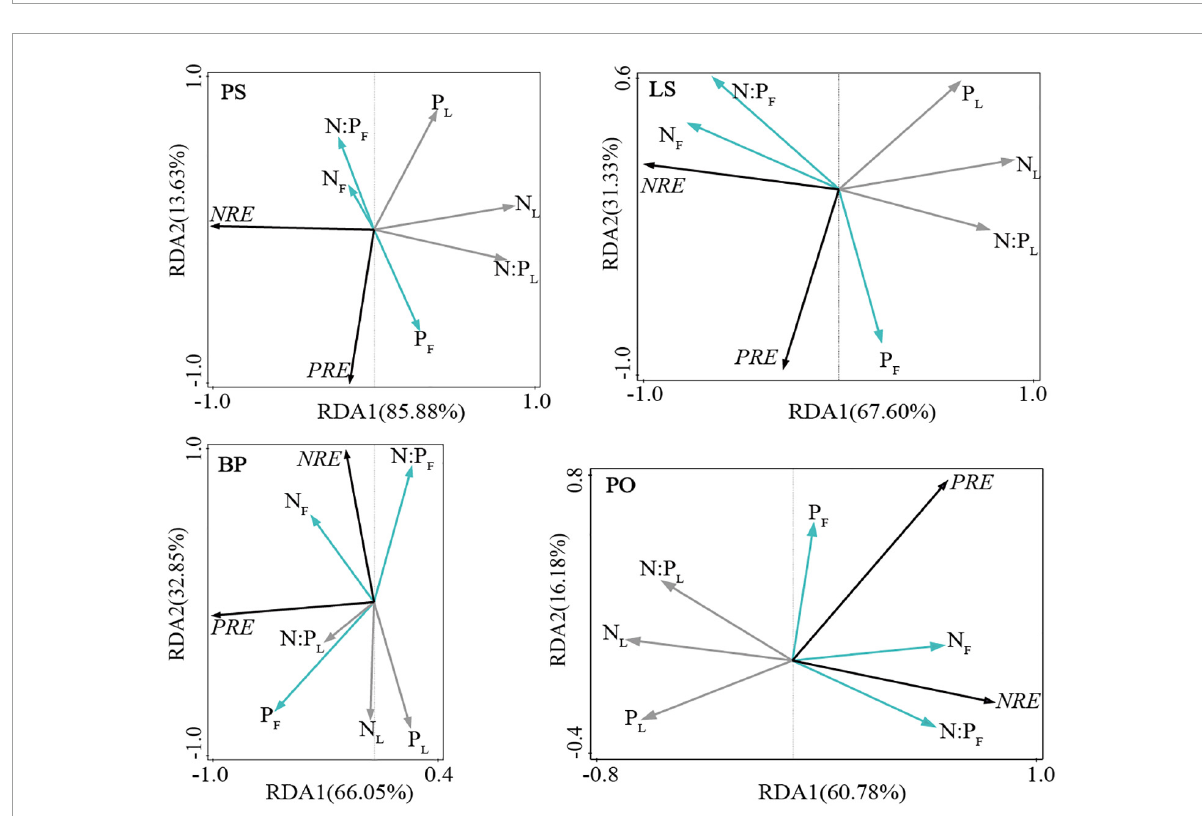
FIGURE4 Redundancy analysis of leaf N, P resorption efficiencies and nutrients concentration and its stoichiometry ratios in different tree species. Fresh leaf N concentration (N F ), fresh leaf P concentration (P F ), fresh leaf N: P ratio (N: P F ), leaf litter N concentration (N L ), leaf litter P concentration (P L ), and leaf litter N: P ratio (N: P L ). Betula pendula (BP), Picea obovata (PO), Larix sibirica (LS), Pinus sibirica (PS), N resorption efficiency (NRE), and P resorption efficiency